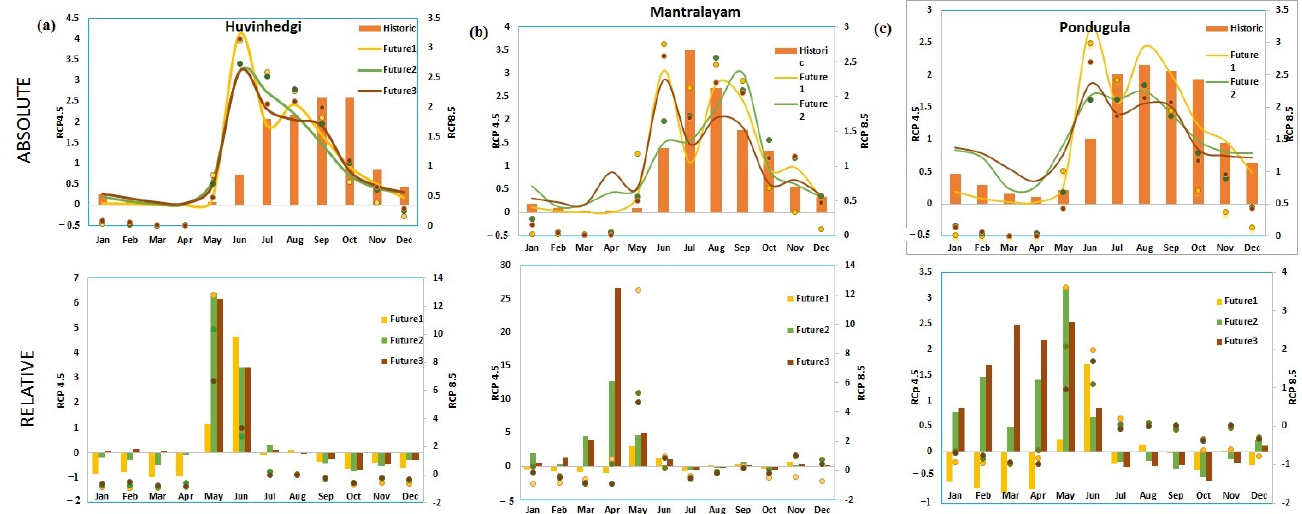
Figure 11. Mean monthly flow as a ratio of mean annual flow for historic and future periods of RCP 4.5 (line plot) and RCP 8.5 (dotty plot) at ( a ) Huvinhedgi, ( b ) Mantralayam, and ( c ) Pondhugula ( top : absolute values, bottom : relative change).